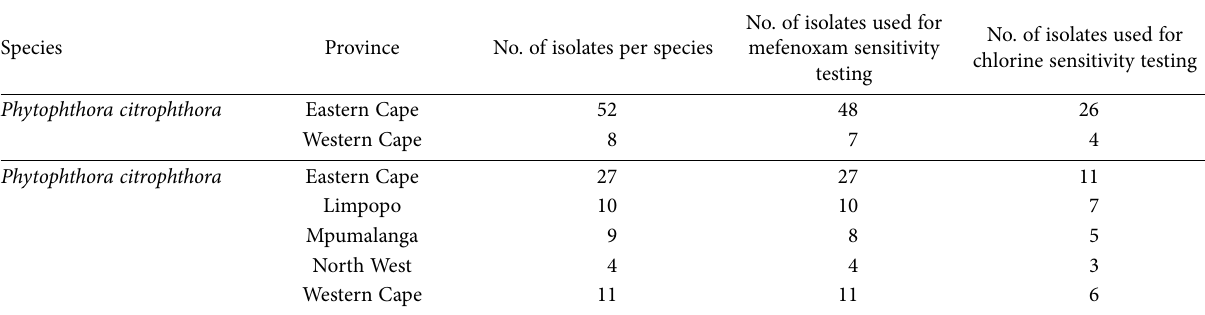
No. of isolates used